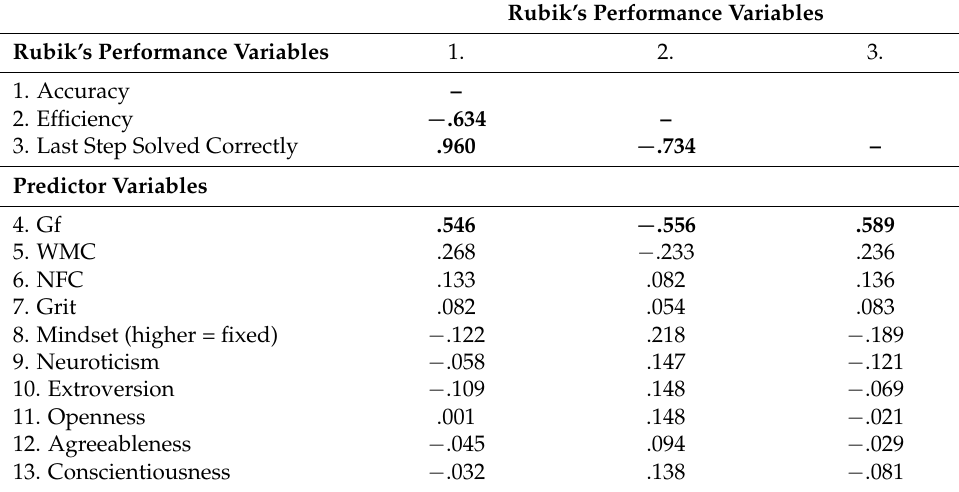
Table 3. Correlations of predictor variables with performance variables.